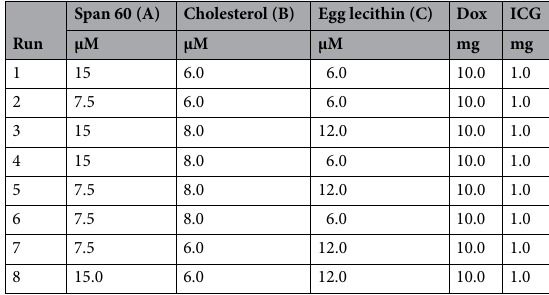
Table 2. Experimental design of 2 3 factorial